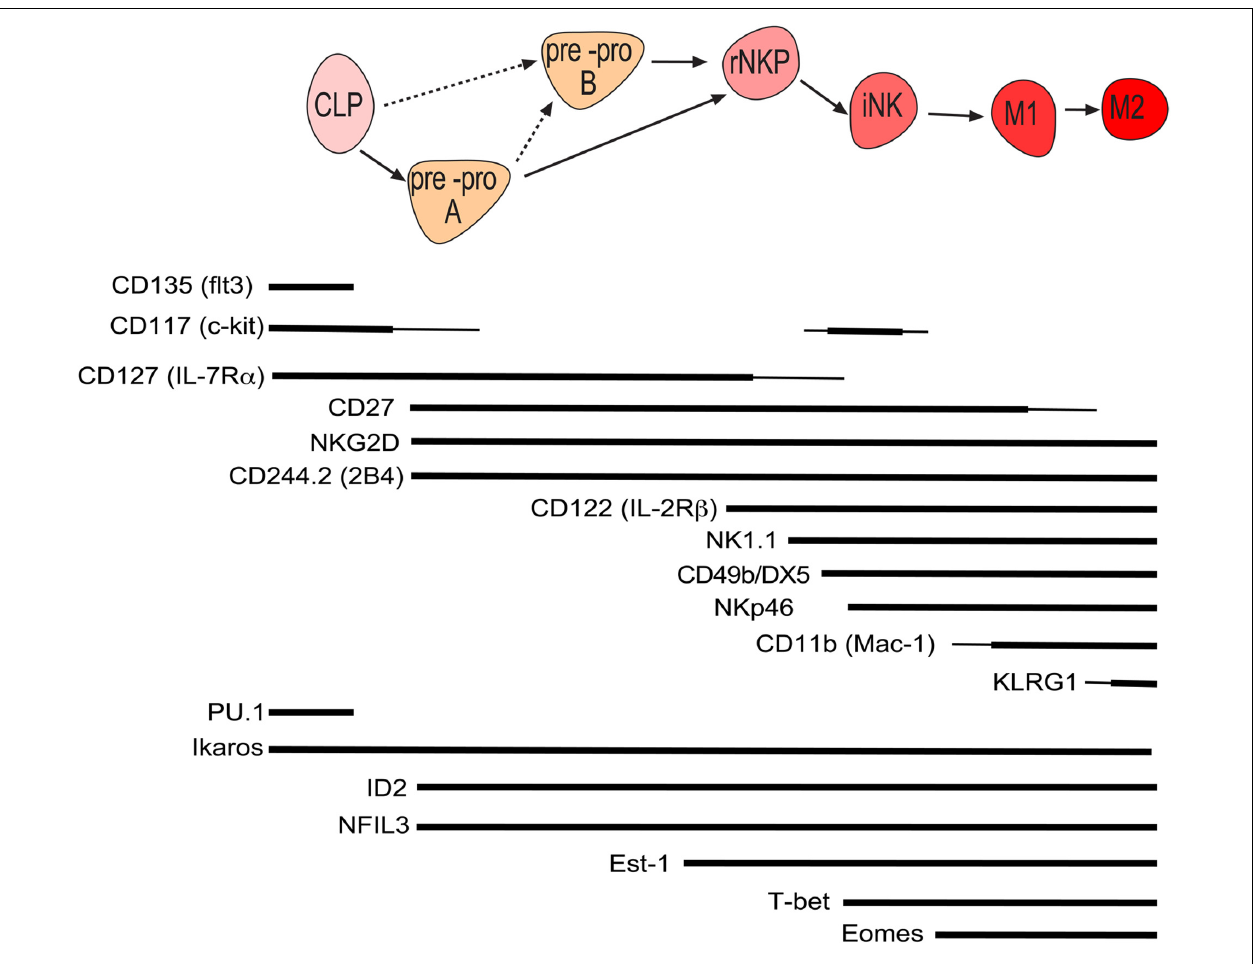
FIGURE 1 | Schematic of murine conventional NK cell development with the cell surface phenotype and required genes at each stage of development. Line width is proportional to expression